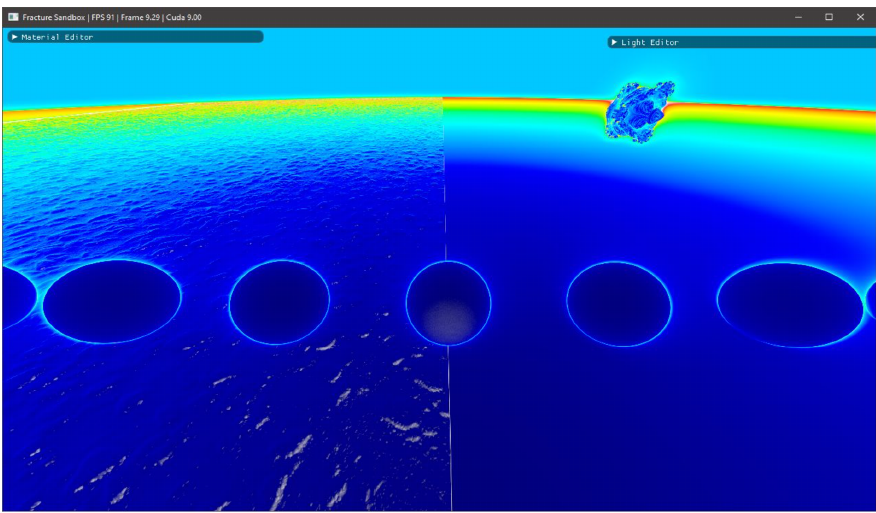
Figure 11. View 3: heatmap illustrating the march iteration